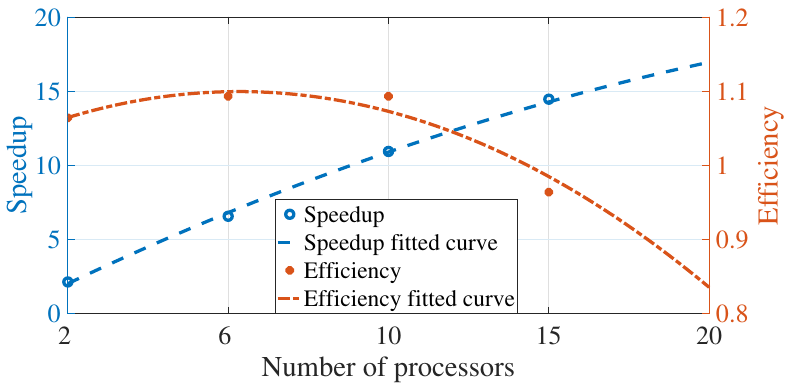
Figure 6. Box plot of the efficiency results.